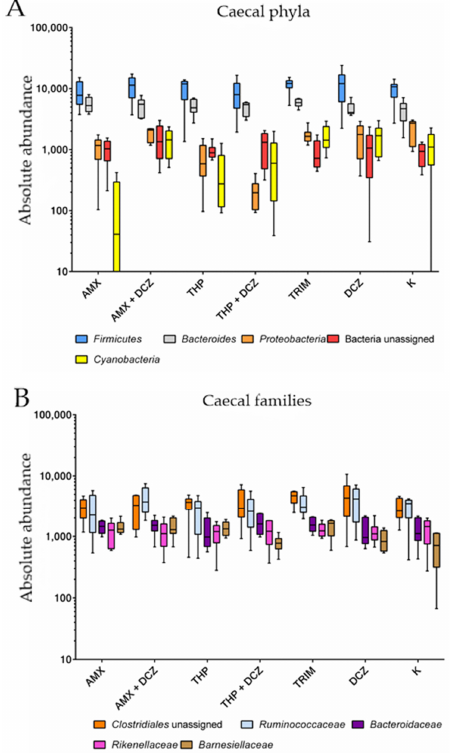
Figure 5. Box plots of two-way ANOVA analysis for caecal phyla ( A ) and families ( B ).